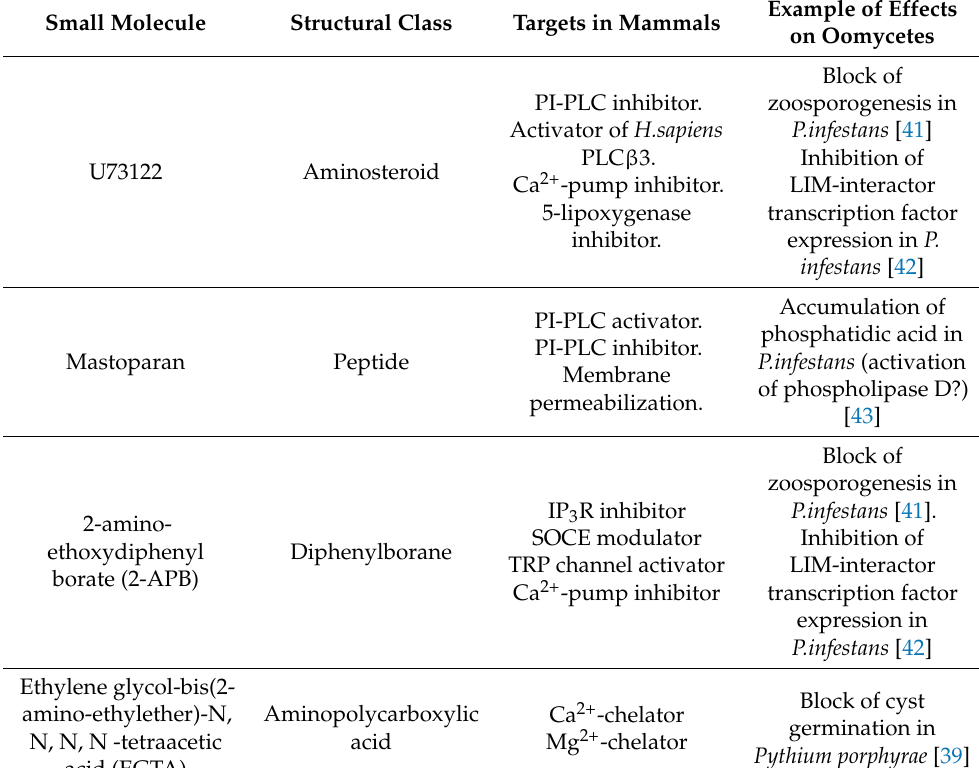
Table 1. Small molecules used to investigate PI signalling in oomycetes. This indicates the structural class, targets in mammalian cells and examples of effects on oomycetes, with accompanying reference